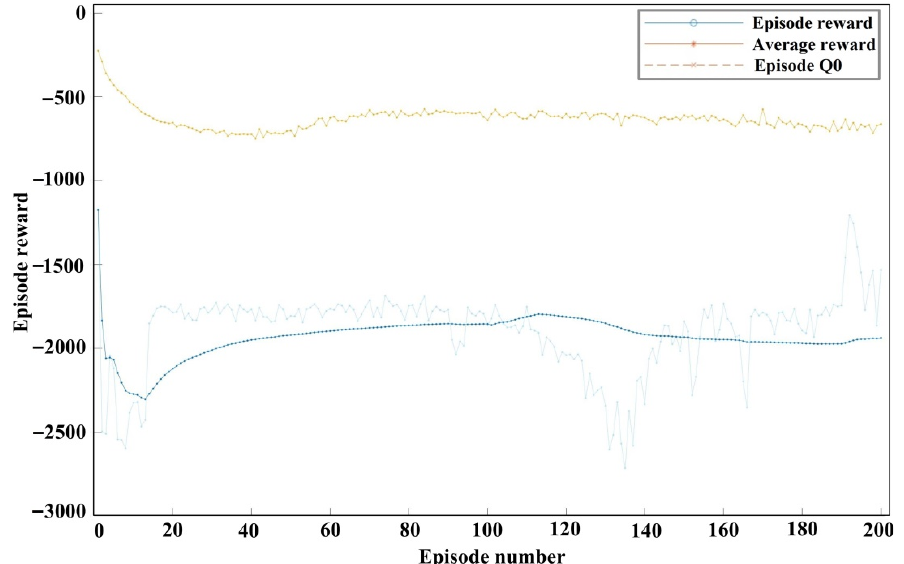
Figure 22. The training stage of the RL-TD3 agent for the correction of the i dref command.